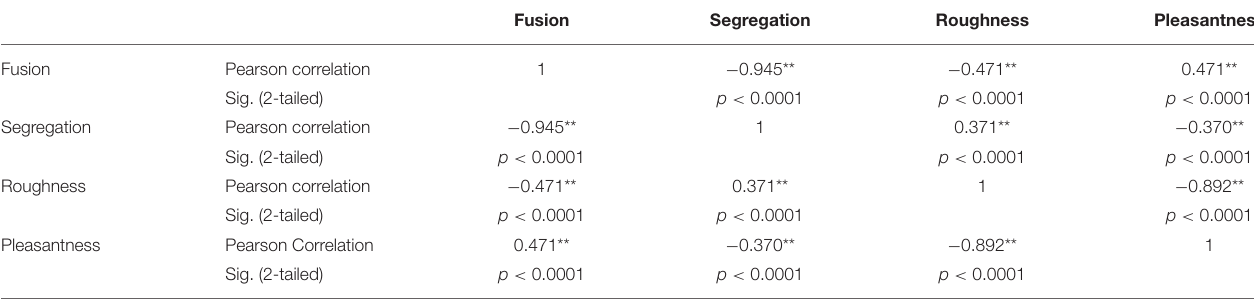
TABLE 2 | Correlation matrix and test results of timbre perception